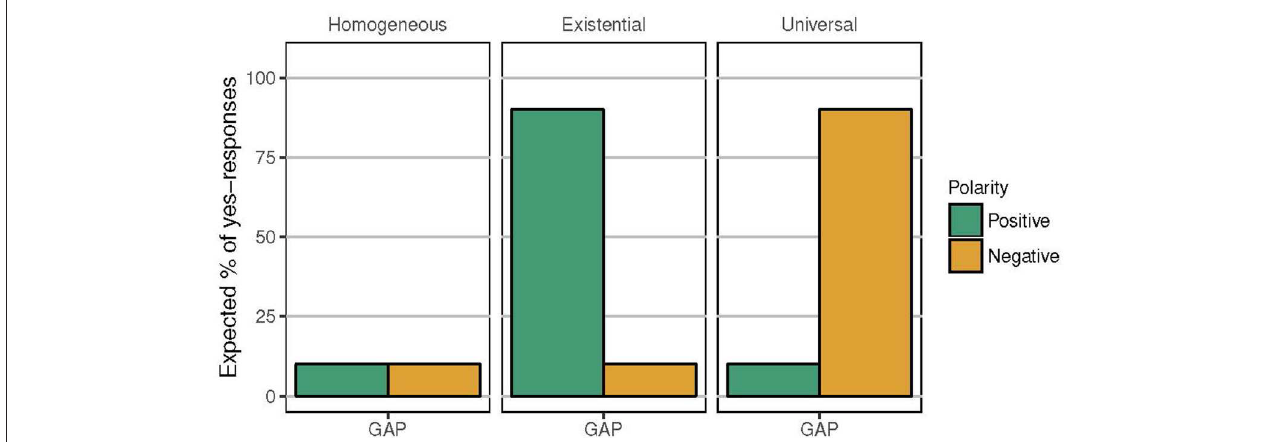
FIGURE 2 | Expected response patterns for positive and negative definite descriptions such as The trucks are blue and The trucks aren’t blue in GAP contexts such as Figure 1 , according to the interpretation of the plural definite